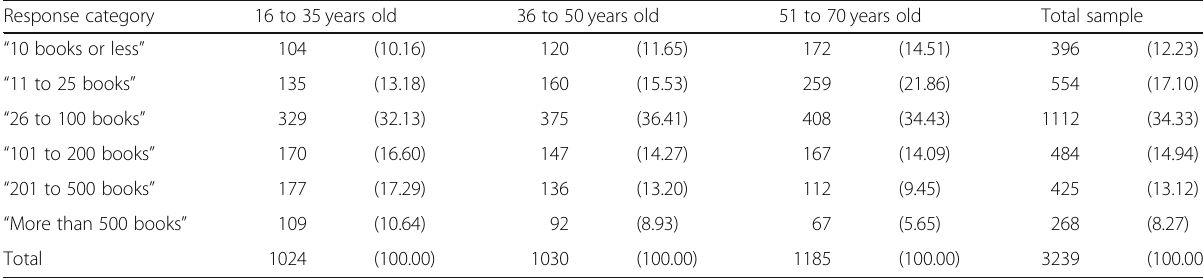
Table 2 The number of books in the home when respondent was 16 years